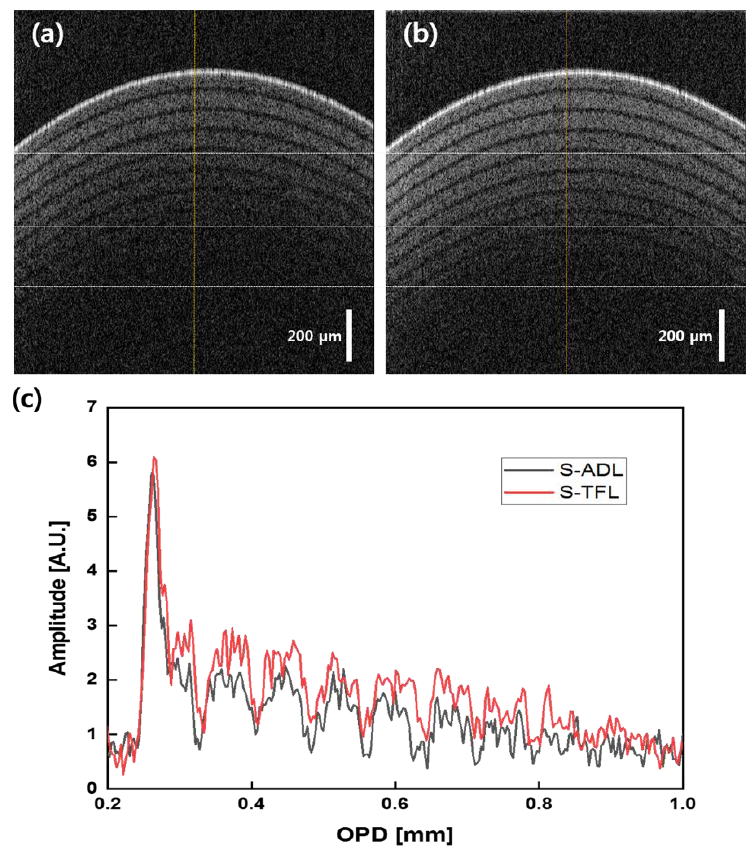
Figure 11. OCT image of a tape obtained using ( a ) S-ADL and ( b ) S-TFL. ( c ) Depth profiles at the same A-line of each image.